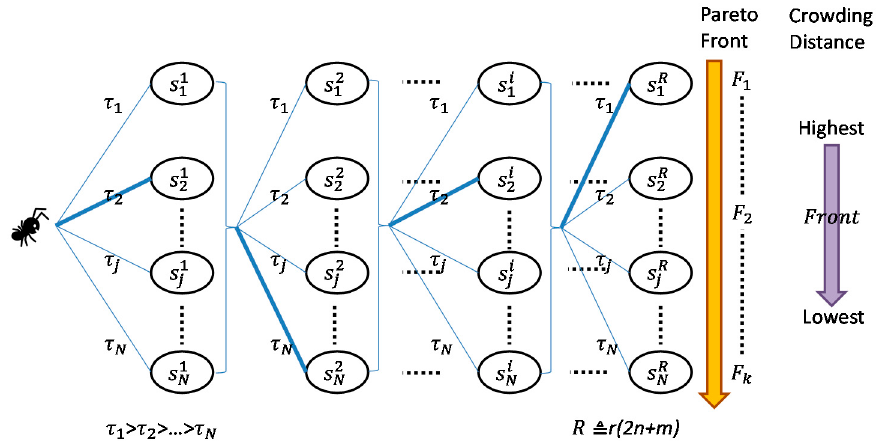
Figure 4. Illustration of the tournament selection, where the bold line denotes a selected path.